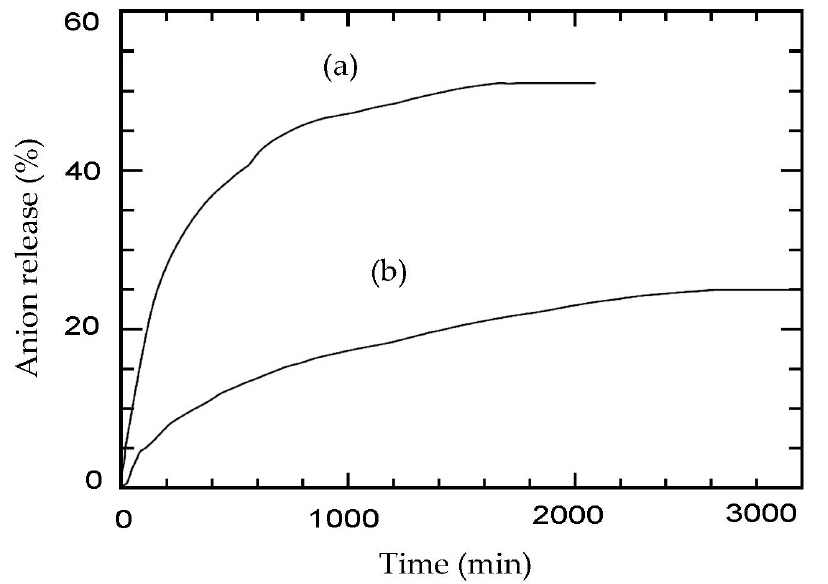
Figure 8. Simultaneous release profiles of (a) TBA and (b) 3,4D from ZADTX into 0.0005 M Na 3 PO 4 aqueous solutions.